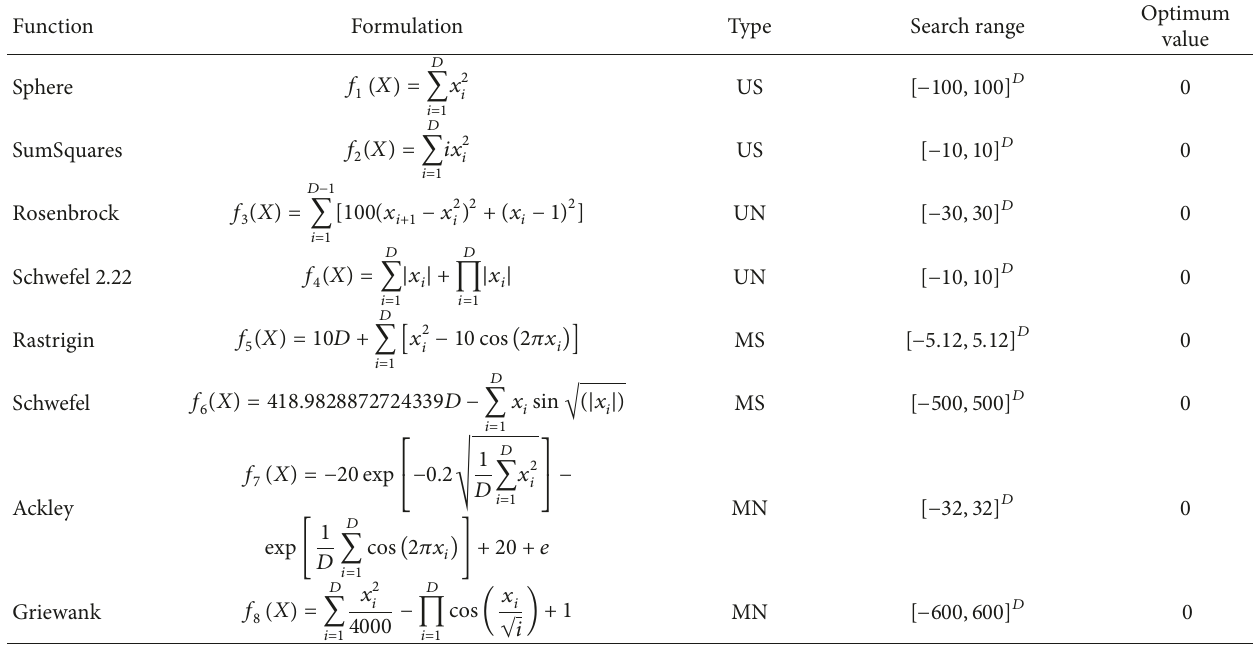
Table 1: Benchmark functions [8, 9].